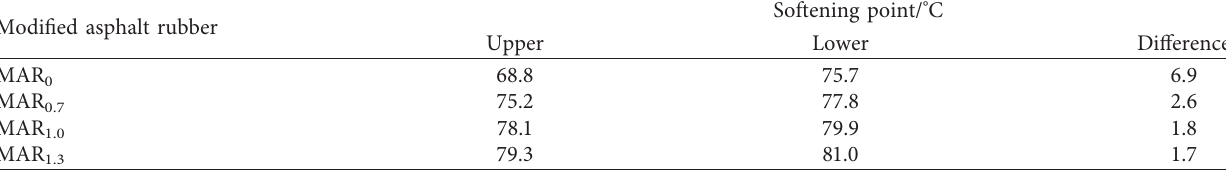
Table 6: Asphalt rubber segregation test